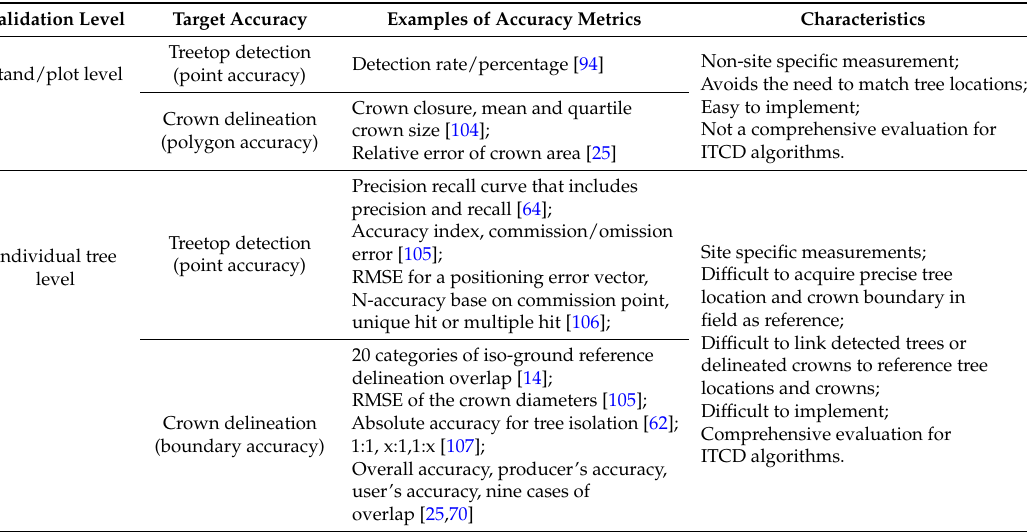
Table 3. Summary of the characteristics of ITCD